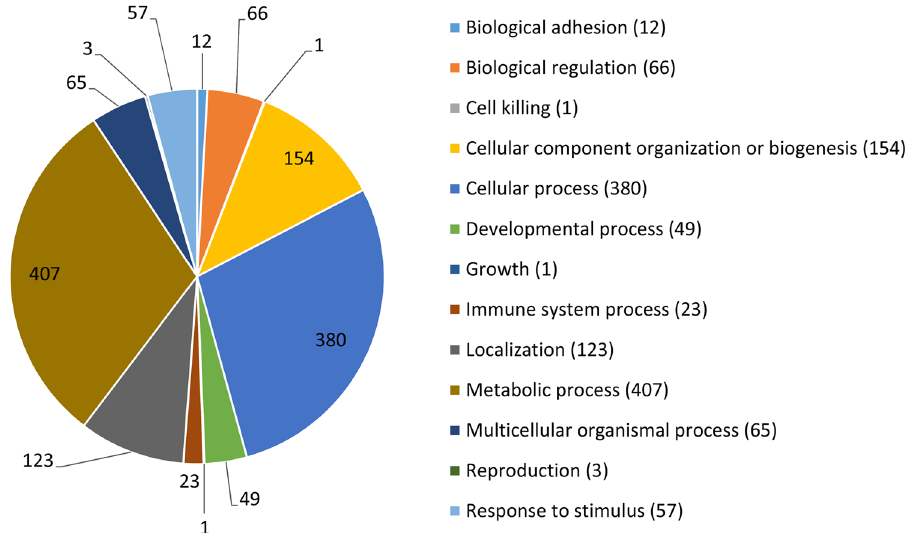
Figure 3. Distribution of proteins. A pie chart showing distribution of the proteins according to their biological process using Panther Classification System. The proteins were classified by their corresponding gene names. 852 of the 1041 proteins were classified into one or more of the 13 groups.